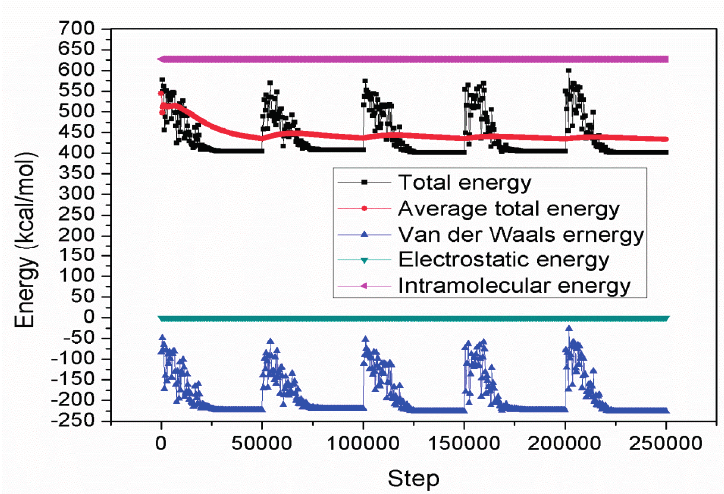
Figure 10. Total energy distribution for THP/Fe (110) surface.